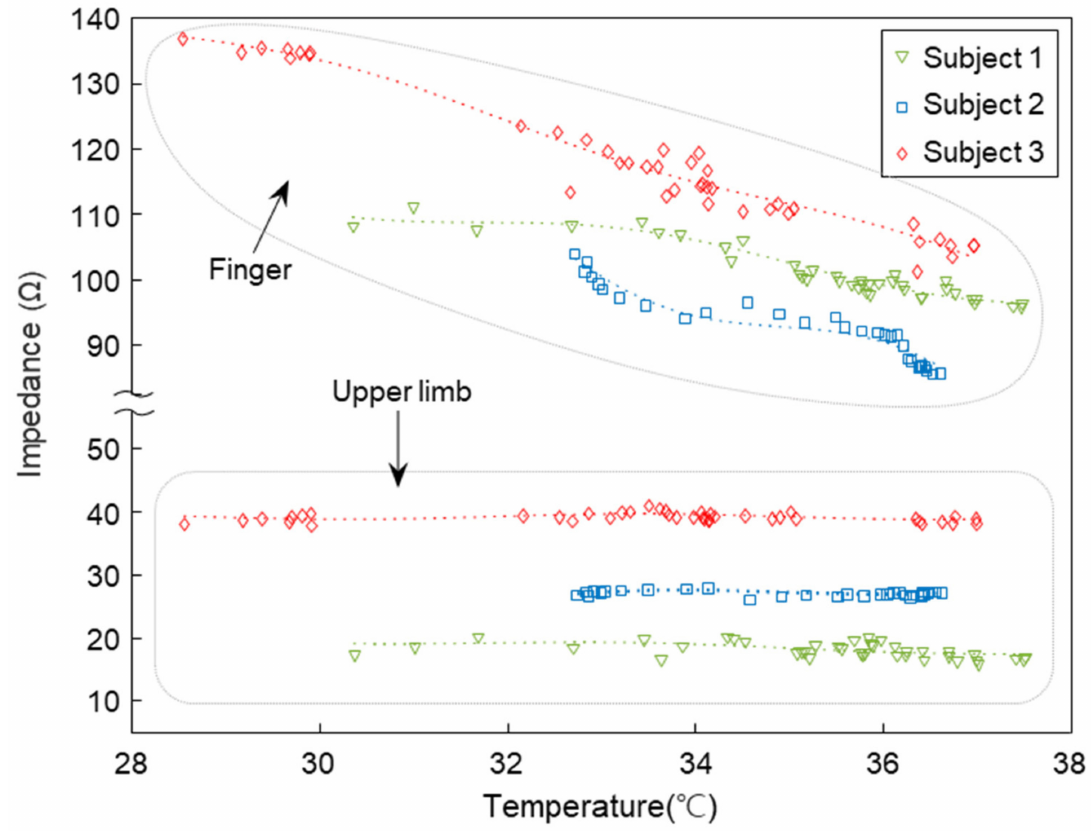
Figure 3. Impedance variation according to temperature. Changes in impedance of fingers and upper limbs acquired by three subjects (Subject 1~Subject 3) according to temperature. The impedance in Y -axis is an average in the frequency range from 20 kHz to 500